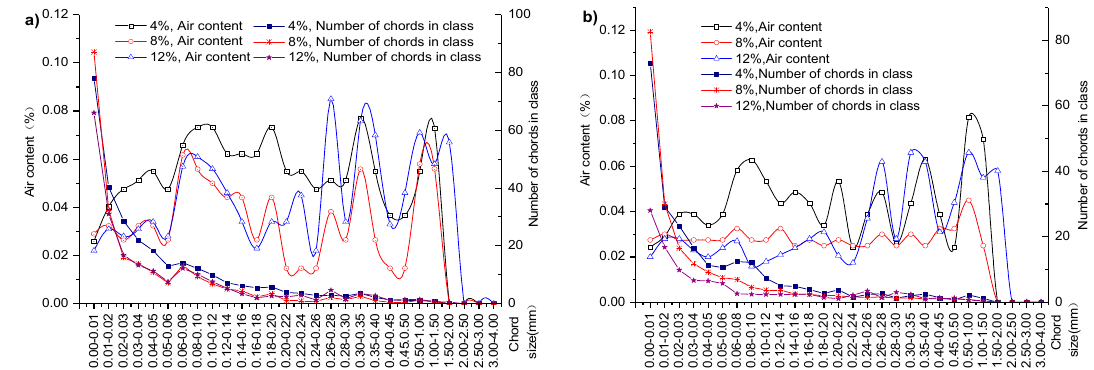
Figure 10. Effect of the three varied expansion agent concentrations on core concrete pore structures: ( a ) without lateral restraint; ( b ) with lateral restraint.